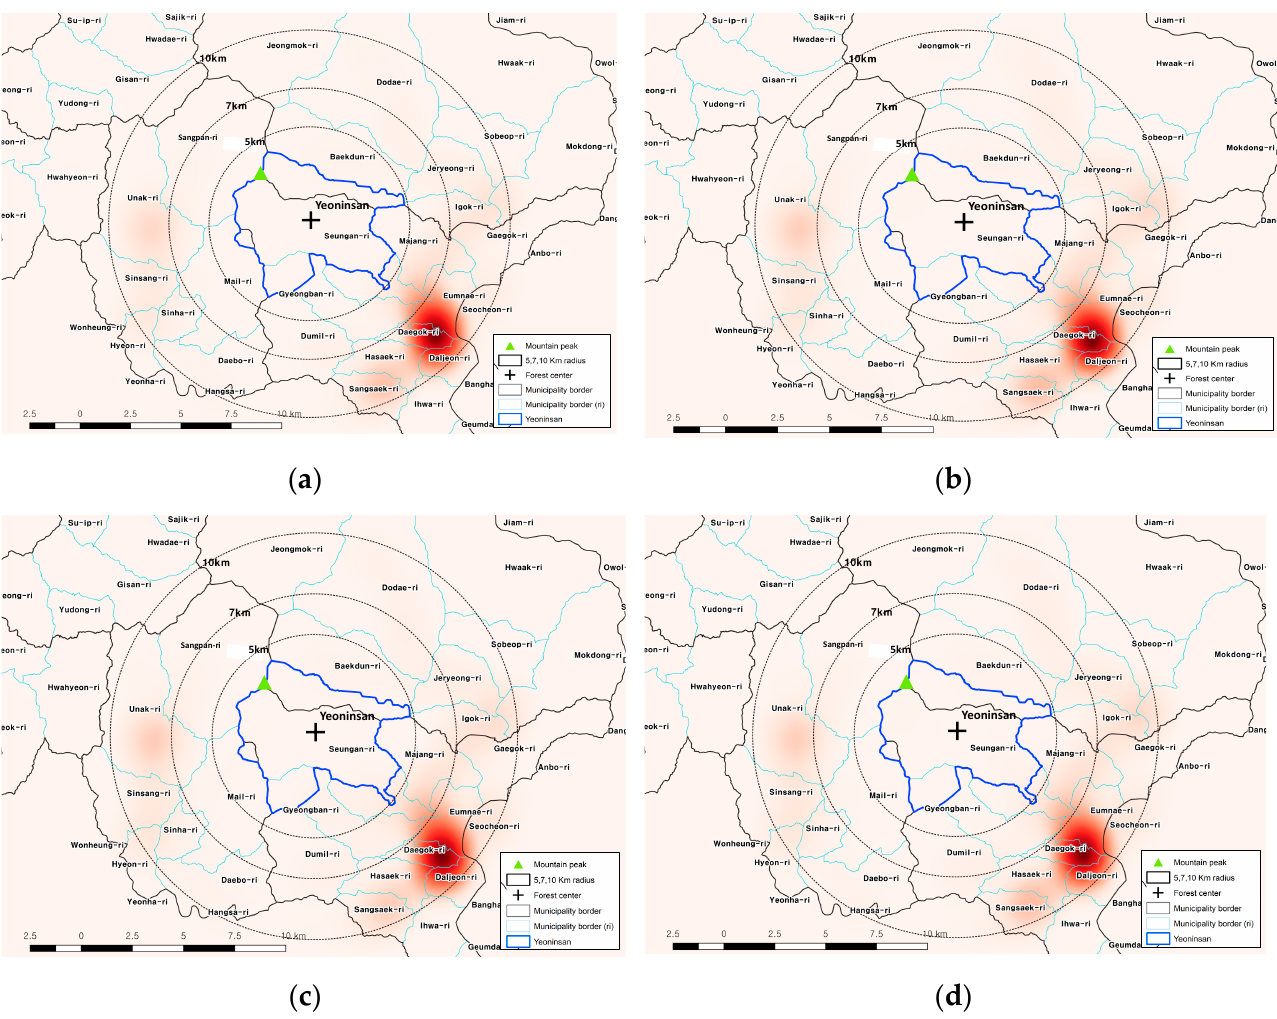
Figure 14. Spatial distribution of the demand intensity of Yeoninsan in ( a ) March, ( b ) June, ( c ) September, and ( d ) December 2019.